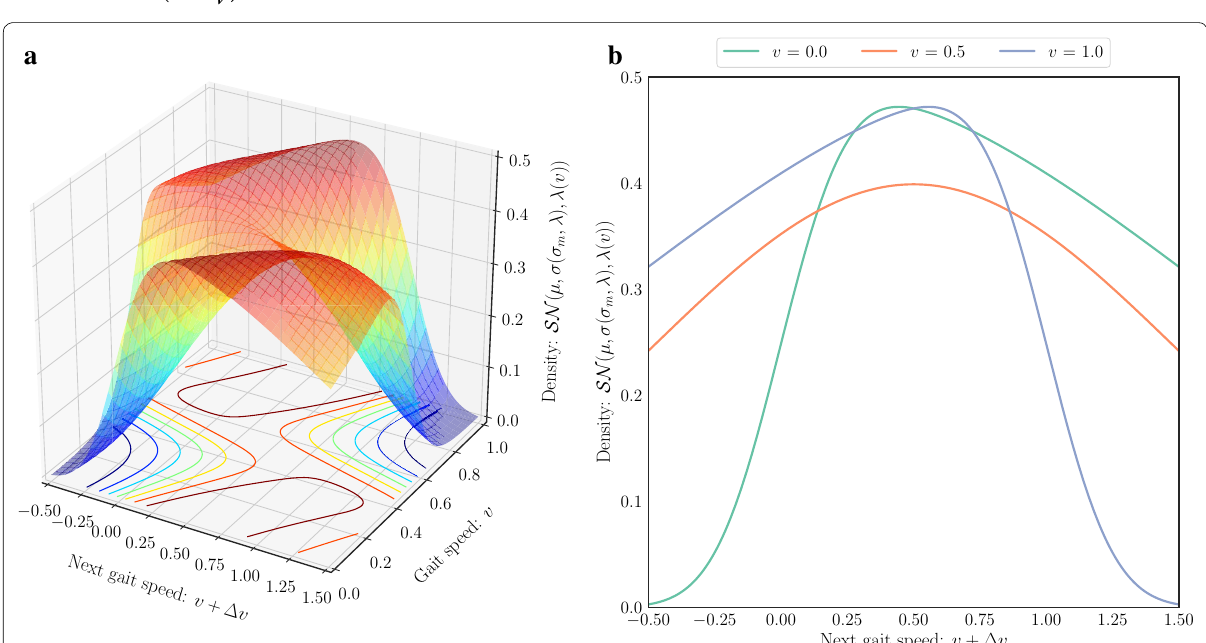
v 0.5 , the skewness is plus since the dynamics tends to accelerate v ; otherwise, it ¯ =